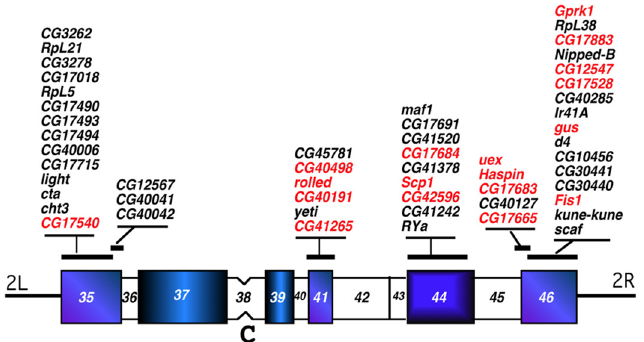
Fig 1. Cytogenetic map of the heterochromatin of chromosome 2 in D . melanogaster . In mitotic chromosome preparations of D . melanogaster , the pericentric heterocromatin has been differentiated into cytogically defined bands using specific chromosome banding techniques [3]. The heterochromatic regions of the left arm of chromosome 2 (2Lh) are numbered from h35 to h37, whereas those of the right arm of chromosome 2 (2Rh) are numbered from h39 to h46. Region h38 indicates the centromere (C). While most heterochromatin genes of the 2L arm appears to be restricted to region h35 (polytenic region 40), genes from the right arm are more scattered being localized in h41, h44 and h46 [52] and thus are separated by megabases of satellite DNA blocks and other repeated DNA sequences [12,13,15]. Only the mapping of the heterochromatic genes studied in this work is reported (see Table 1). For a more detailed map see Dimitri et al. [52]. The mapping of a group of Drosophila heterochromatin gene orthologs in D . virilis and D . pseudoobscura was retrieved from the work of Schaeffer et al, (supplemental Tables 21 and 24, [35]; these genes are shown in black, while the orthologs mapped in this work are shown in red. The heterochromatin of chromosome 2Rh was estimated to contain at least 12.1 Mb DNA [14], while according to the genomic coordinates of Release 6.03 it encompasses 5.2 Mb. This apparent discrepancy can be explained considering that heterochromatin scaffolds (named 2R-Het or 2R-U in the previous Release 5.1 [48] have been incorporated as an uninterrupted sequence in Release 6.03, without taking into account that those scaffolds are separated by megabases of satellite DNA stretches that are not included in the sequence [12, 13,